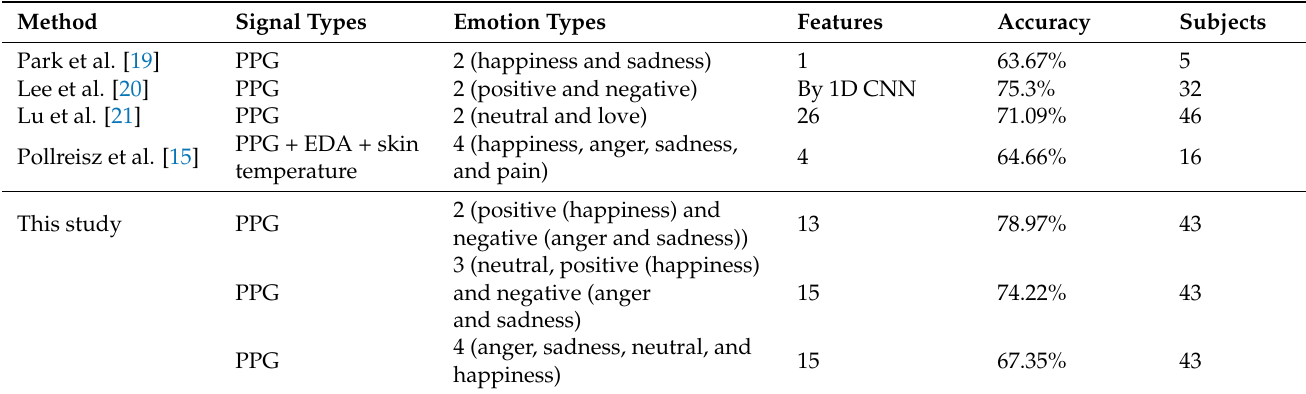
Table 7. Comparison with other relevant